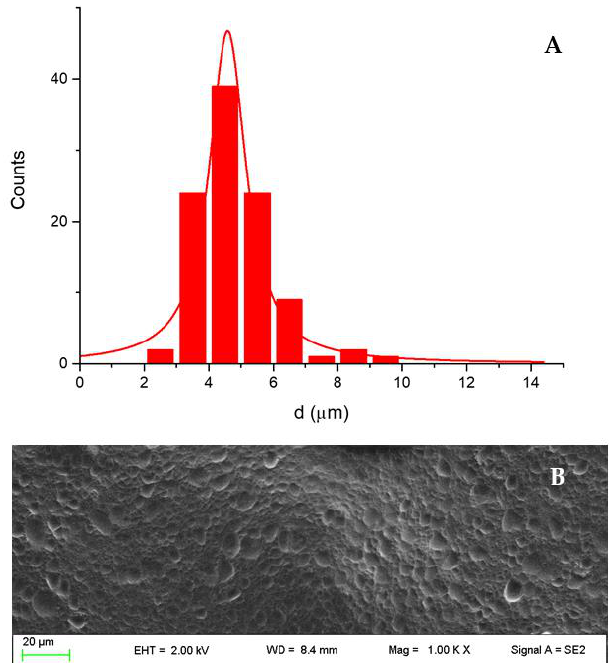
Figure 13. ( A ) Dimensional distribution of the internal oil phase droplets; ( B ) SEM micrograph of the emulgel.